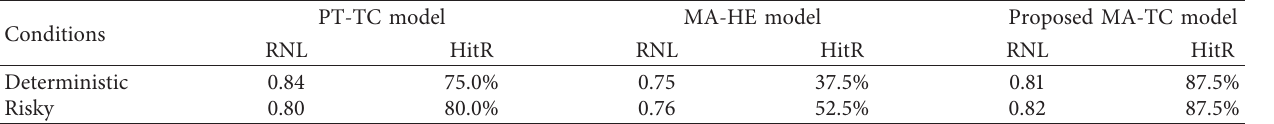
Table 7: Prediction accuracy of models.